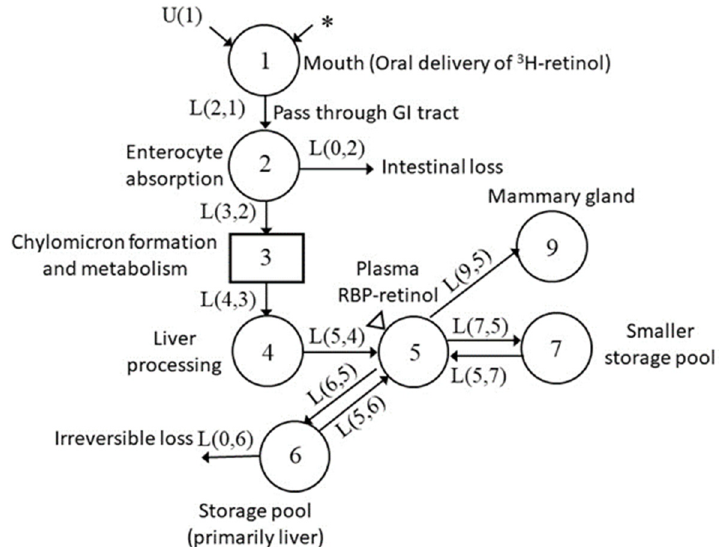
Figure 7. Proposed model for VA tracer kinetics in pregnant–lactating rats during lactation. Each circle represents a different compartment, the rectangle represents a delay component, arrows indicate the transfer of VA from one compartment to another compartment. The asterisk indicates 3 H-labeled retinol dose entering the system, U(1) indicates the dietary intake of VA, and the triangle indicates the site of sample collection. Table 4. Kinetic parameters at different physiological stages for rats in the pregnant–lactating group 1 .